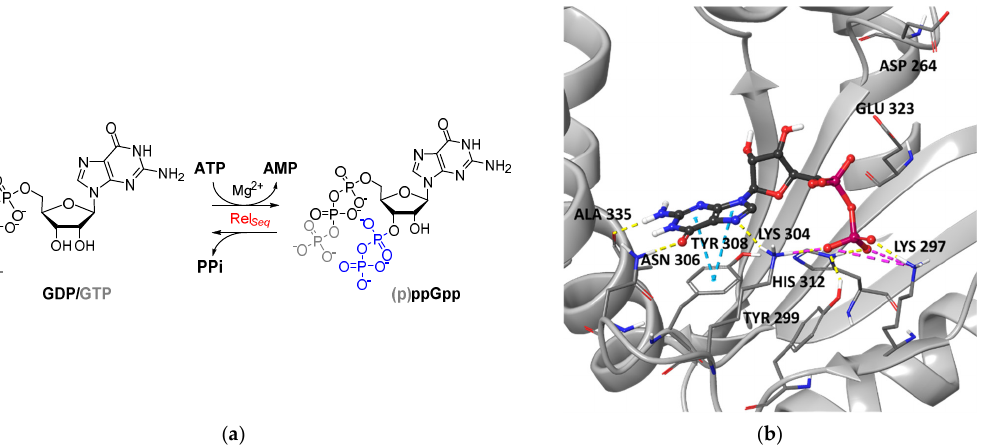
Figure 1. ( a ) Enzymatic reaction that regulates intracellular (p)ppGpp levels catalyzed by RSH enzymes such as Rel Seq ; ( b ) X-ray structure of GDP in the SYNTH site of Rel Seq (1VJ7, chainA). GDP is represented in ball and stick, and the key interacting amino acids are labeled.